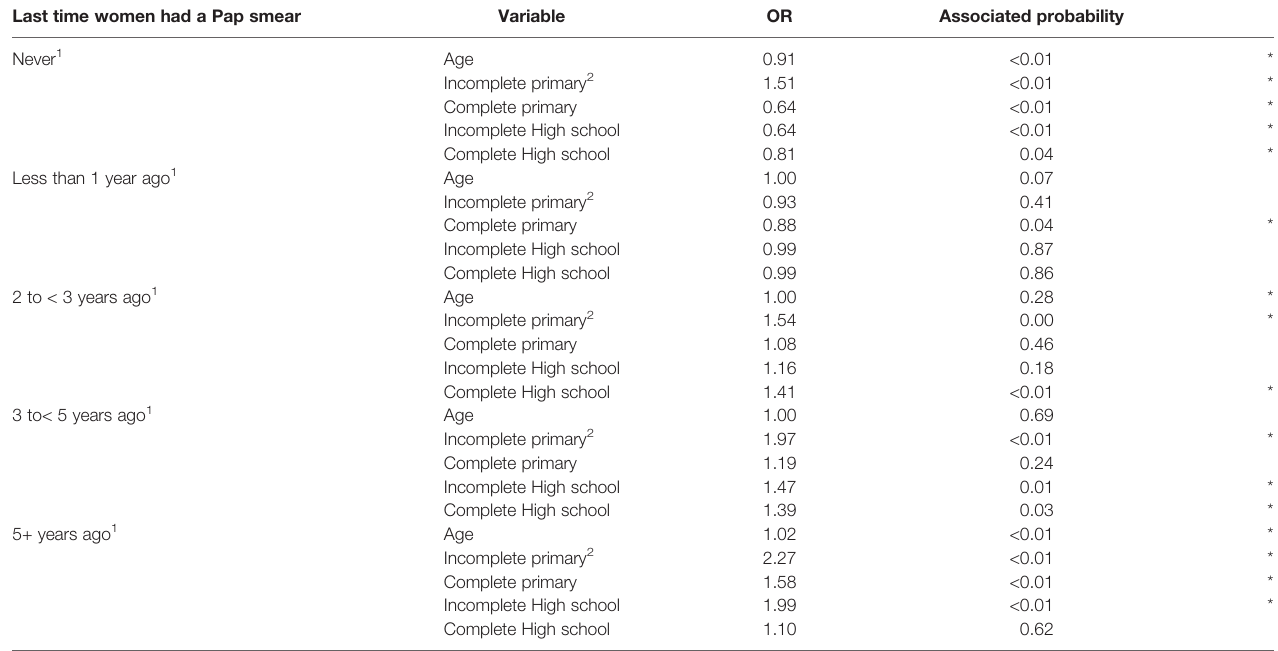
TABLE 3 | Last time women had a Pap smear, by age, educational attainment, and marital status. Last time women had a Pap